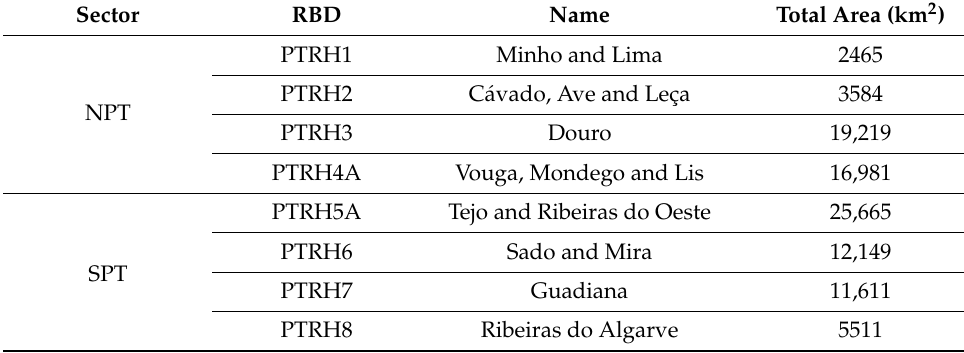
Table 1. Portugal’s River Basin Districts organized by sector NPT and SPT